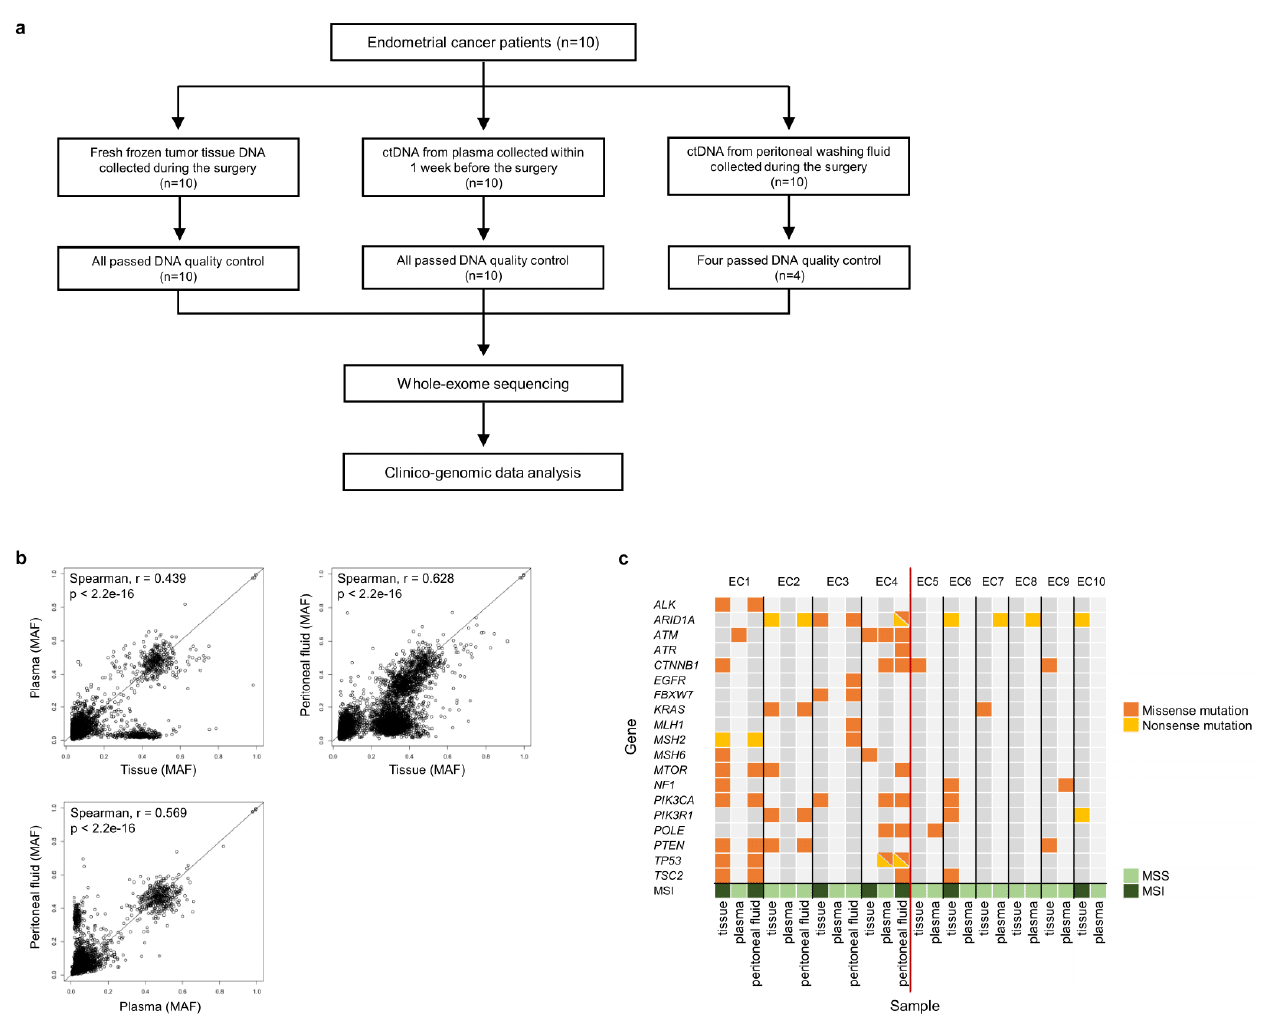
Figure 1. ( a ) Patient flow chart. ( b ) Comparison of mutant allele frequencies of the mutations shared between tissue and plasma, tissue and peritoneal fluid, and plasma and peritoneal fluid. The mutant allele frequencies (MAF) are shown on the x -axis and y -axis. ( c ) Somatic mutations and